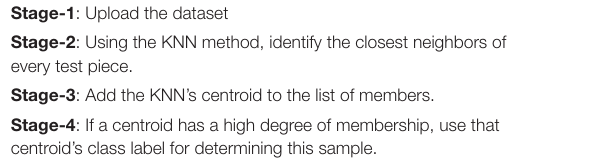
Algorithm 1 : | Procedure of